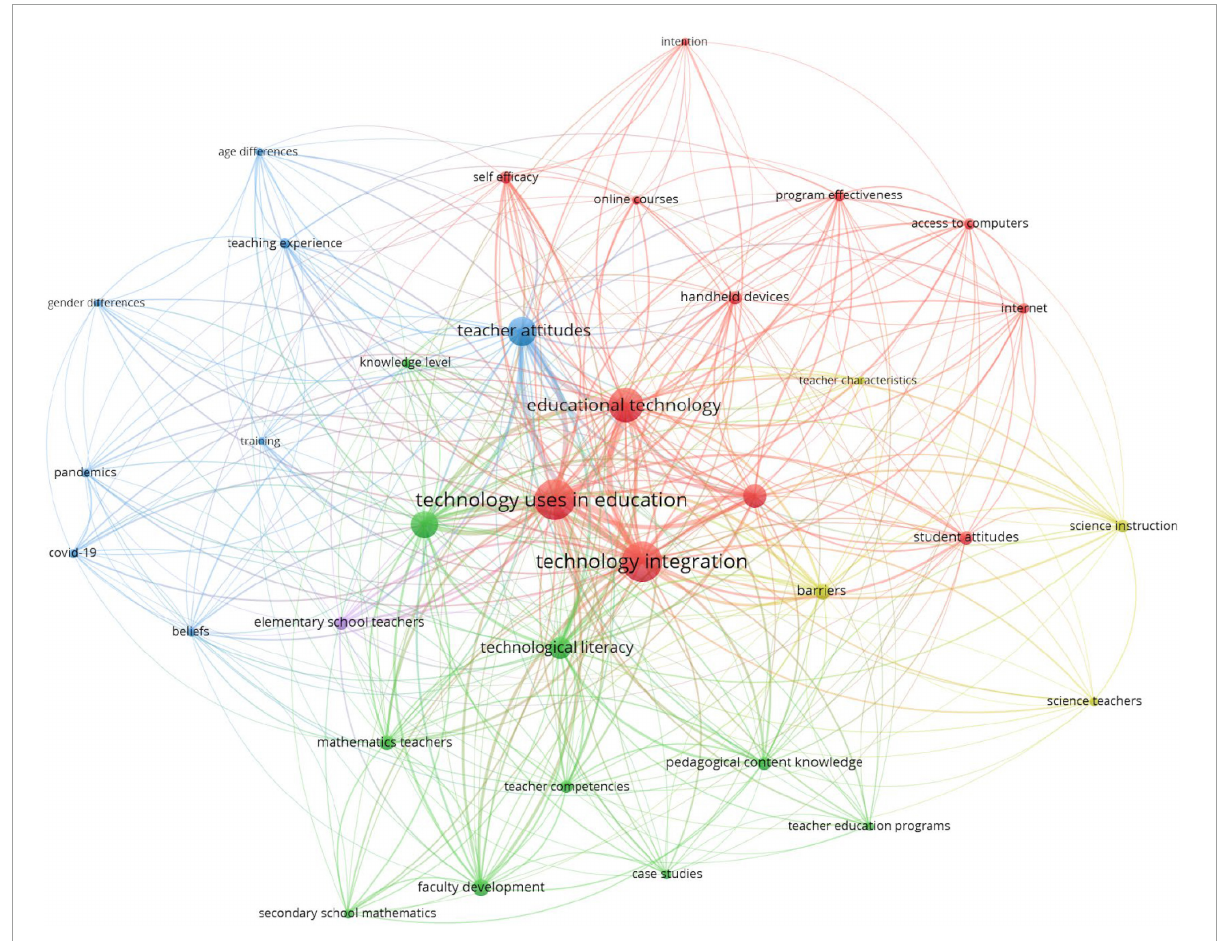
FIGURE2 Conceptual network on the integration of digital technologies in the classroom